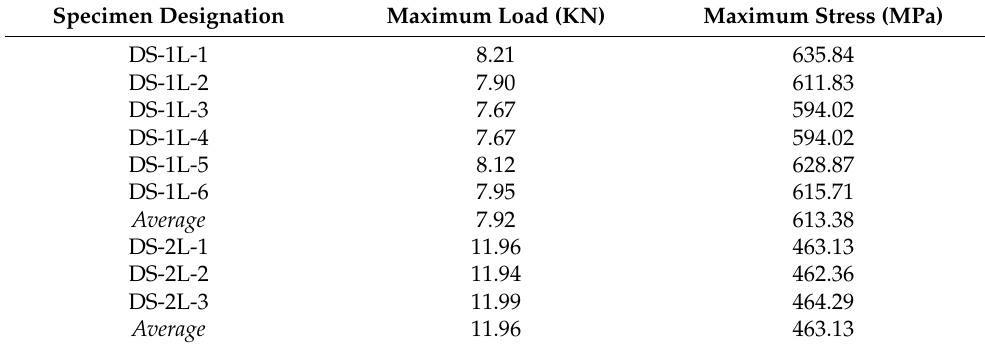
Table 2. Bond test Table 2. Bond test results.